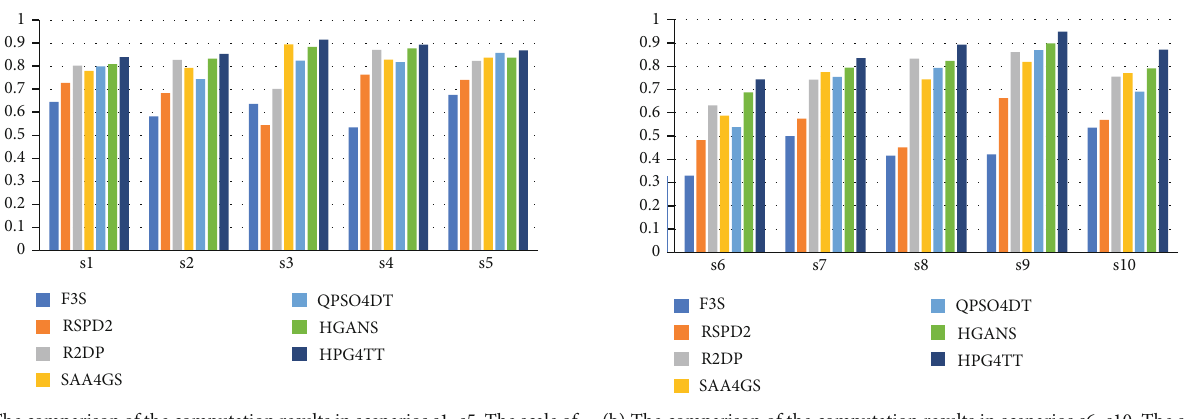
(a) The comparison of the computation results in scenarios s1 – s5. The scale of (b) The comparison of the computation results in scenarios s6 – s10. The scale the scenarios is small and there are some data topics that consist of no relation of scenarios s6 – s10 is larger than that of s1 – s5 and the data topics only consist observation data units of weak relation and strong relation observation data units Figure 7: The comparison of the computation results of di ff erent algorithms.